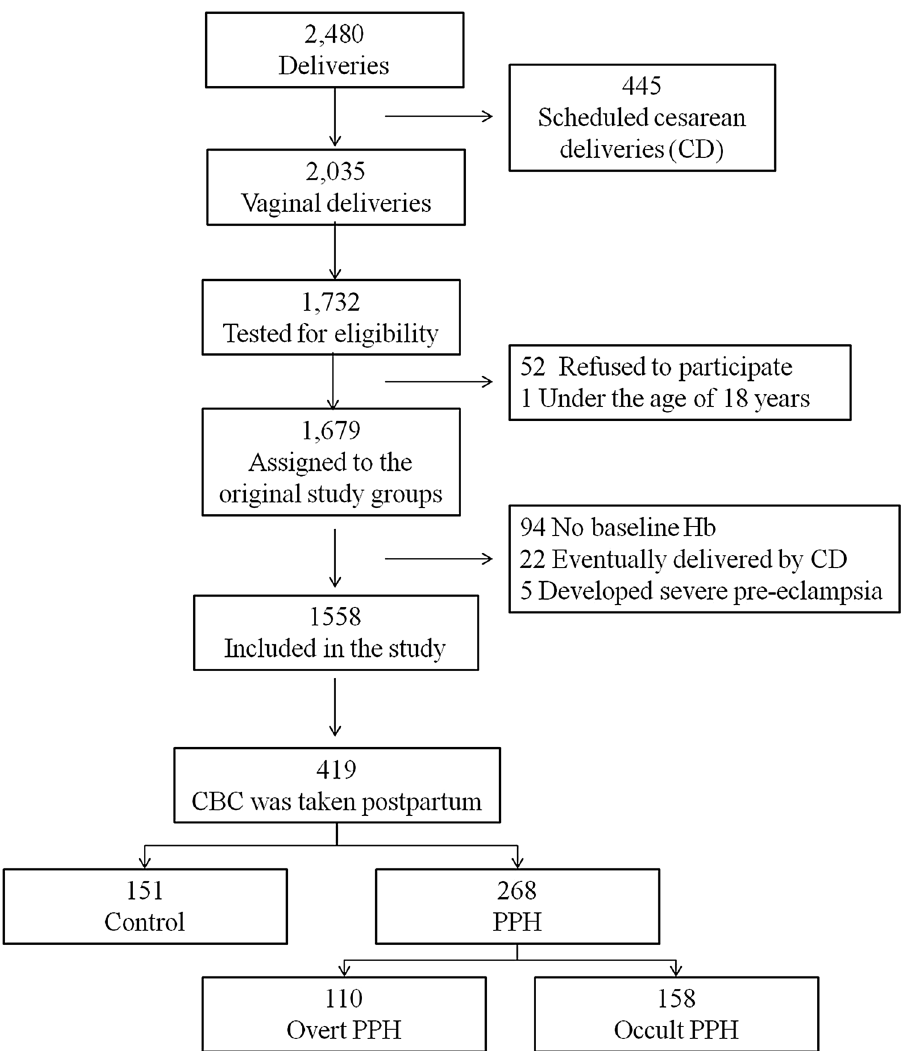
Figure 1. Patient disposition flow chart. CBC complete blood count, CD caesarean delivery, Hb hemoglobin, PPH postpartum